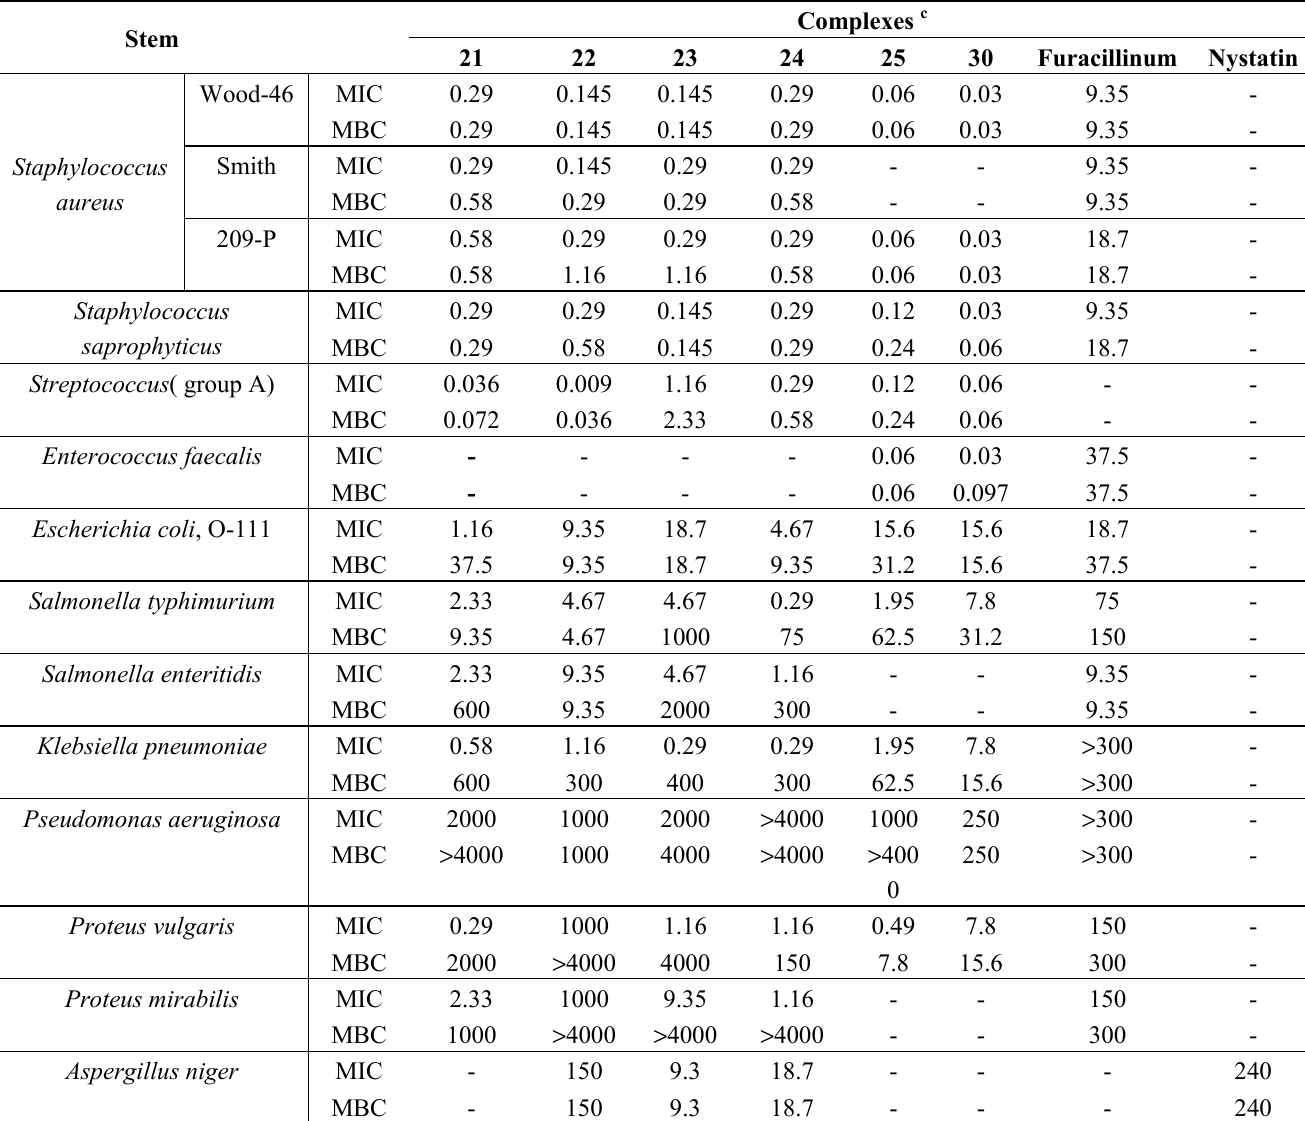
Table 5. Antimicrobial or antifungal activity (MIC a /MBC b ) ( μ g/mL) of some copper